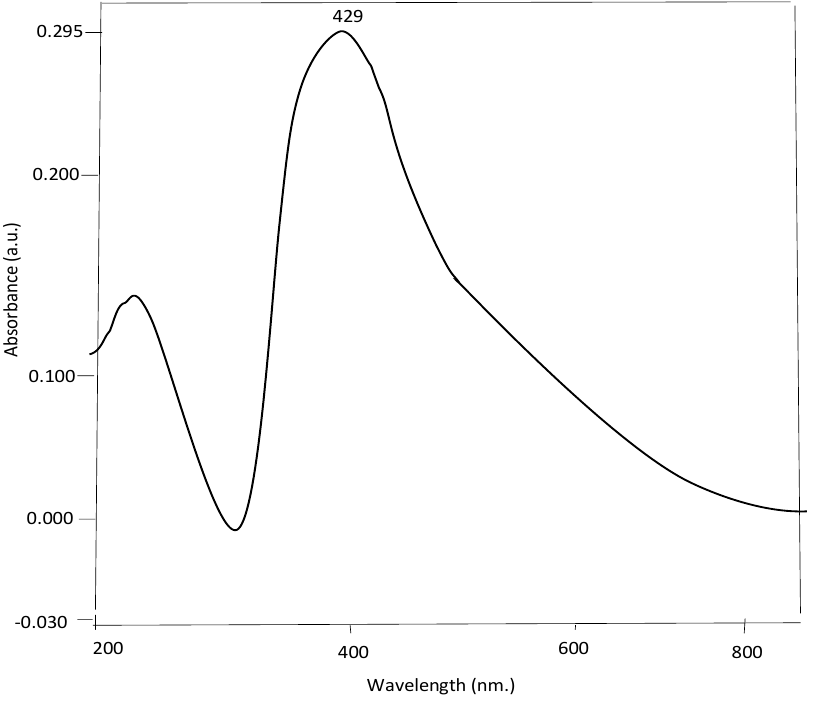
Figure 2: UV-Vis Analysis of Biosynthesized AgNPs.